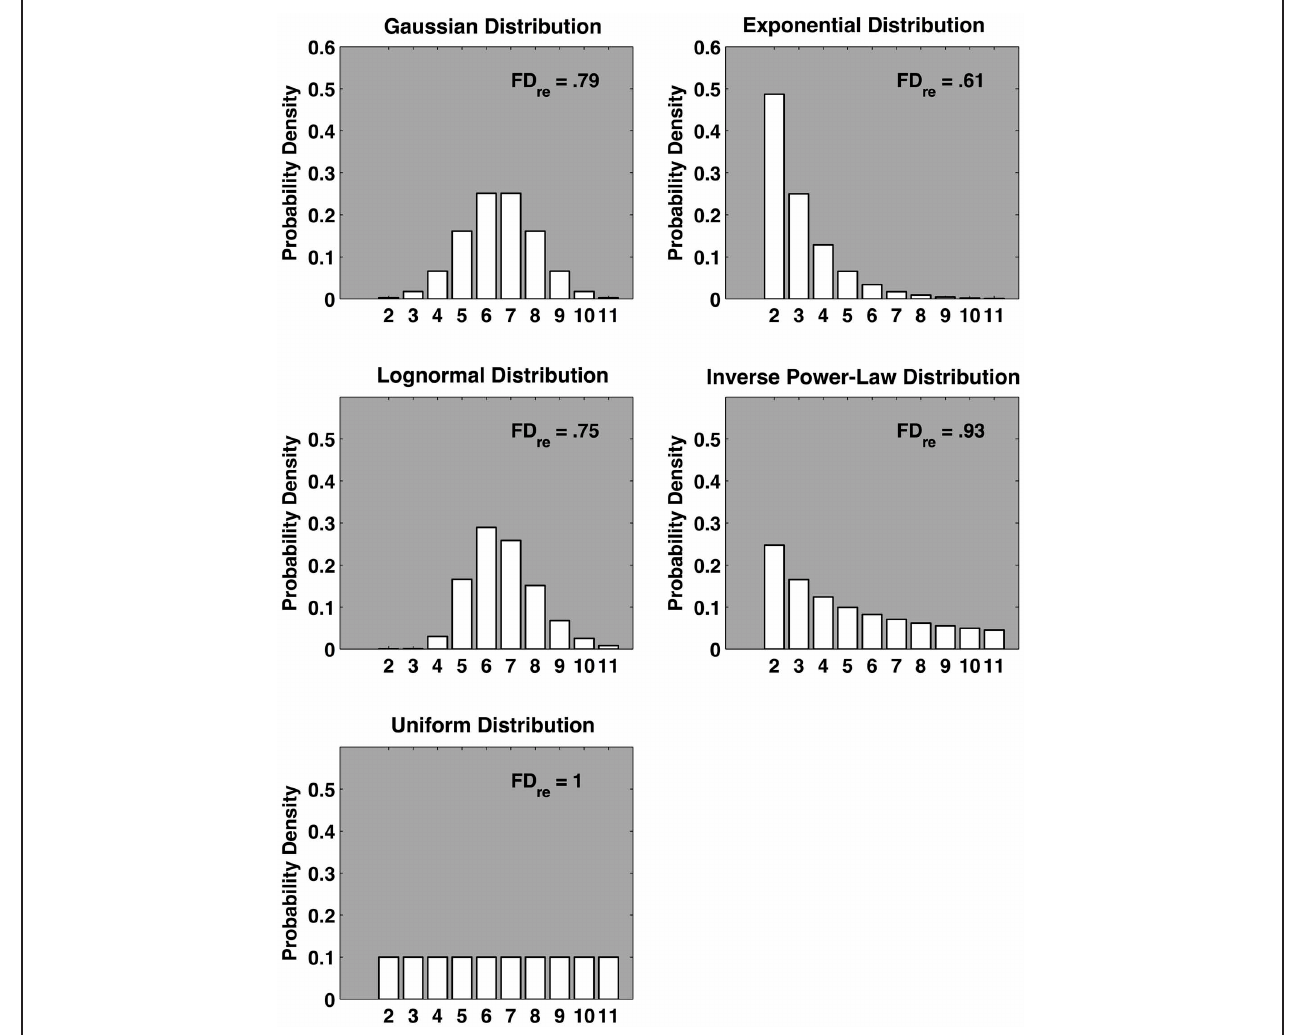
component-dominant dynamics and interaction-dominant dynamics (see text for details). The uniform distribution is included to define the upper boundary for FD re . The fractal dimension gauges the relative variability of the respective distributions; the more evenly dispersed, the larger the FD re